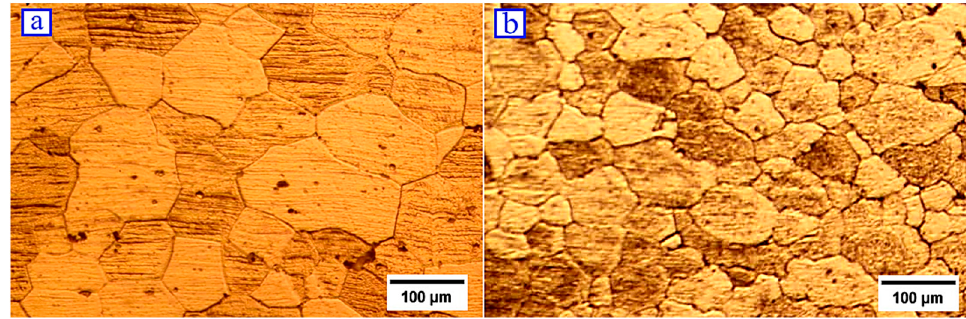
Figure 6. Optical micrographs of HAZ: ( a ) unprocessed and ( b ) processed with FSP.